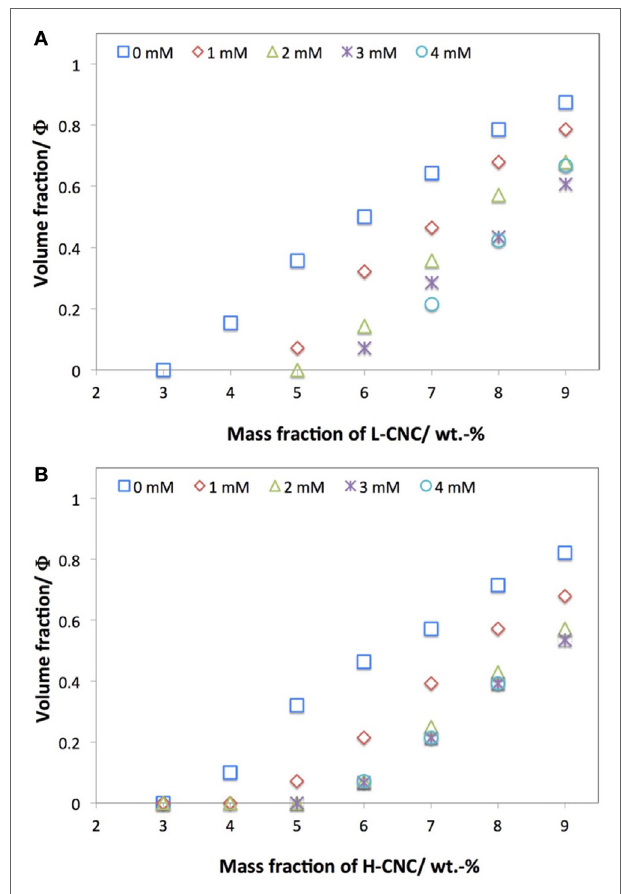
FigUre 3 | Phase separation in suspensions of cellulose nanocrystals (a) l-cnc; (B) h-cnc in pure water at different cnc mass fractions w , as indicated on each vial cap . The volume fraction Φ of cholesteric phase (bottom, bright between crossed polarizers) is plotted quantitatively for both series in the diagram in (c)